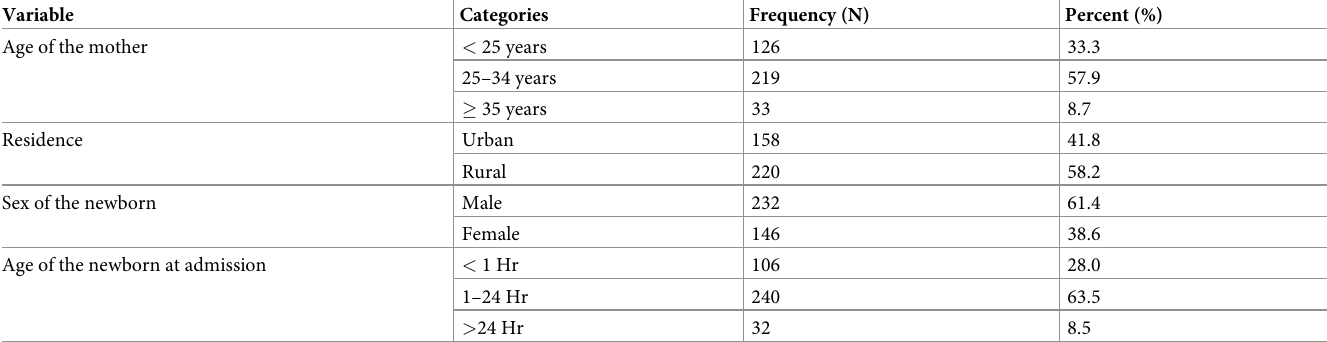
Table 1. Sociodemographic characteristics of the study subjects in DCSH, Amhara region, Northeast Ethiopia (N = 378).